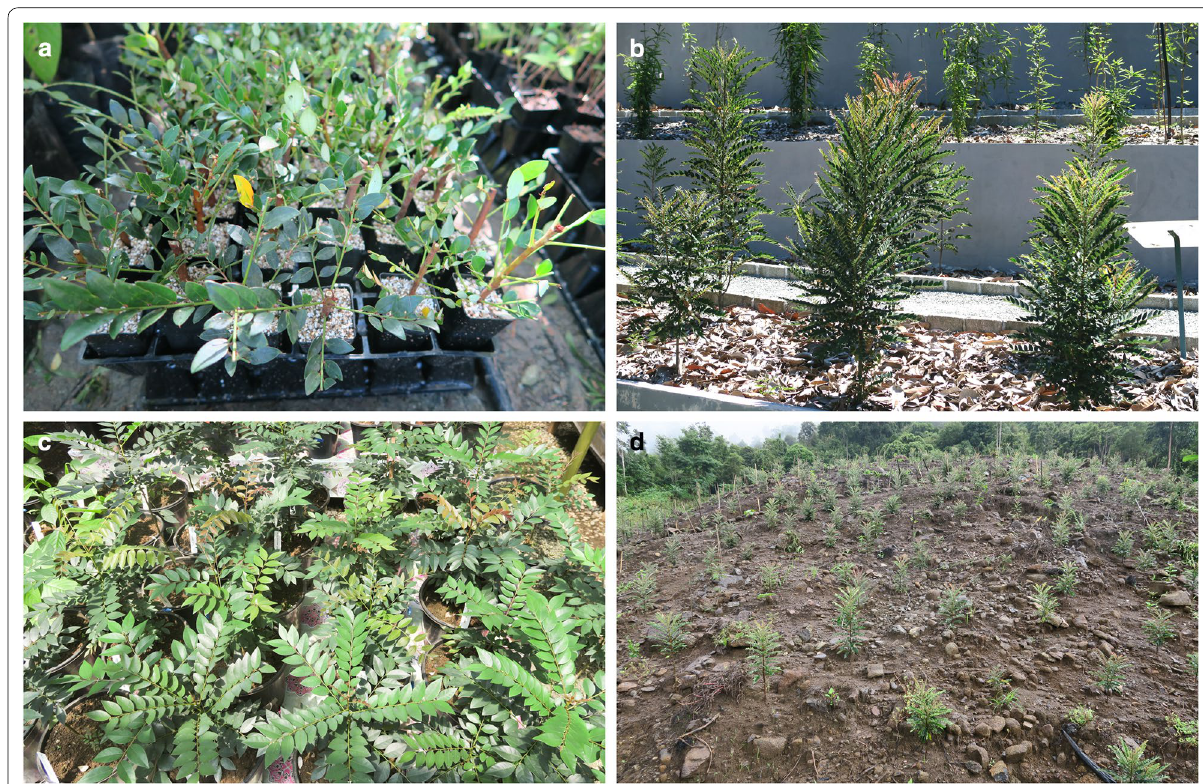
Fig. 5 Agromining growth trials using P. rufuschaneyi in Sabah, Malaysia. a Mass propagation of P. rufuschaneyi using cutting grown in perlite; b Phyllanthus rufuschaneyi shrubs planted out in the ‘Hyperaccumulator Botanic Garden’ of Sabah Parks; c plant nutrition growth experiment using P. rufuschaneyi at Monggis substation; d full-scale (1.5 ha) agromining field trial using P. rufuschaneyi near Pahu village 6 months after